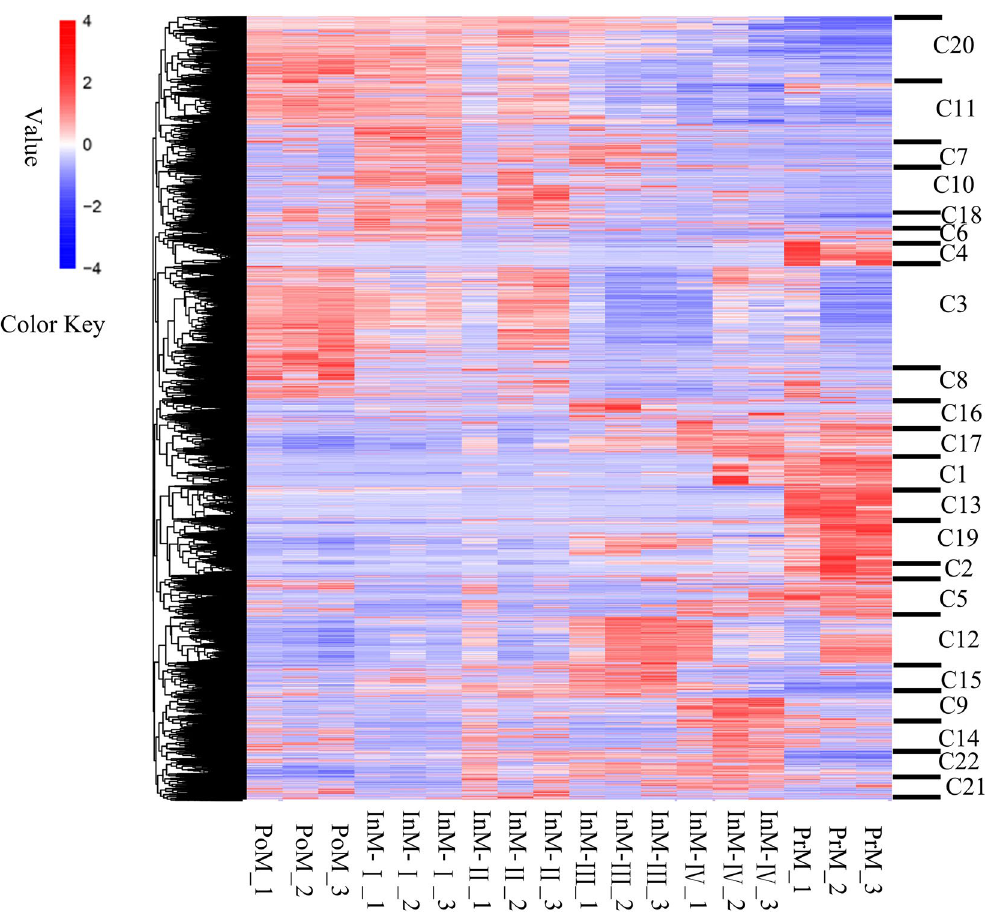
Figure 3. Heat map of DEGs clustered in two ways: molting stages and GO categories. Each stage has three replicate samples. C1–C22 functional clusters of DEGs. Color key value indicates the fragments per kilobase of exon per million mapped fragments (FPKM) fold